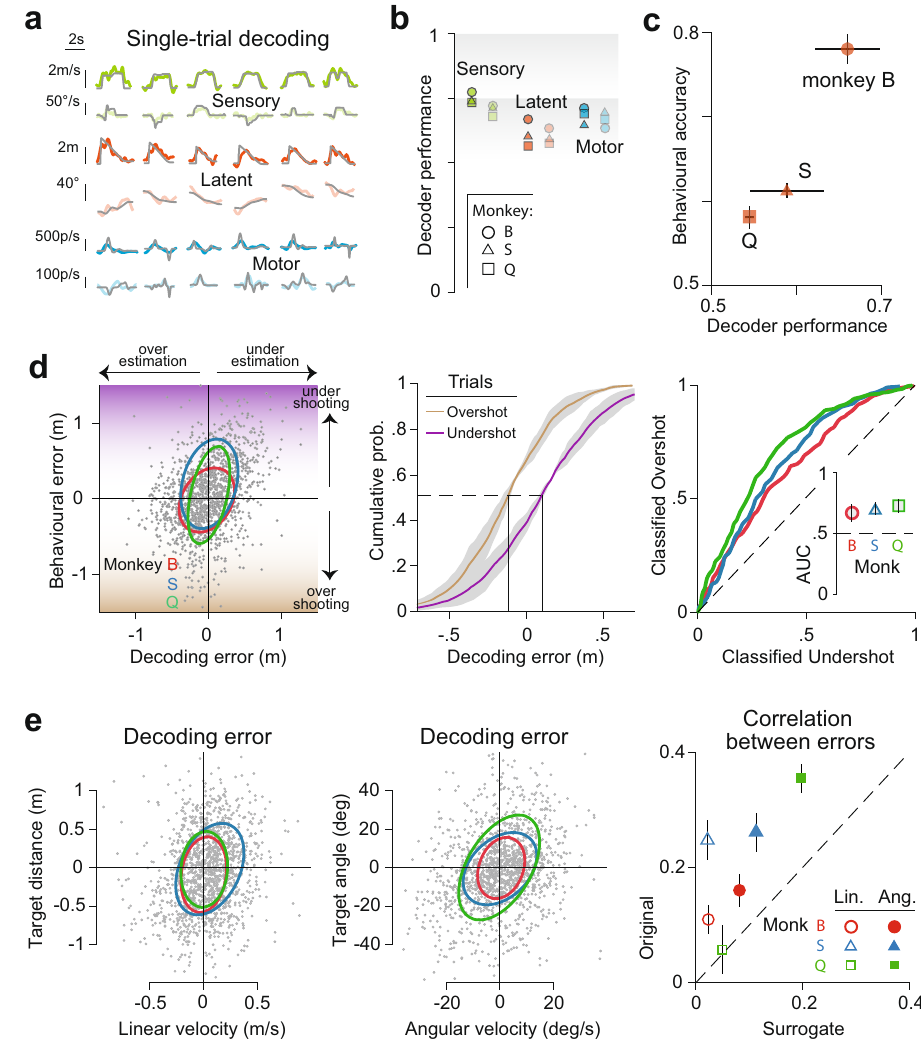
Fig.5|Populationactivitypredictsbehavioronindividualtrials.a Wetraineda linear decoder using ordinary least-squares to decode task variables from popu- lationactivity(Methods).Columnscorrespondtosixrepresentativetrialsandrows correspond to different variables (linear velocity, angular velocity, target distance, targetangle,andhandvelocityalongthetwoleadingprincipalcomponentsofhand position).Graytracescorrespondtogroundtruth. b Decoderperformanceforeach variable, quanti fi ed as the correlation between observed and decoded estimates shown separately for individual monkeys. c Average performance of the decoder for distance-to-target plotted against the mean behavioral accuracy (fraction of correct trials) of different monkeys. d Left: Error in decoding distance to target is correlated with the behavioral error (difference between target distance and stopping distance) across trials. Middle: The cumulative distribution of decoding error shown separately for trials in which the monkey undershoots (purple) or Fig. 5e — right). This suggests that neural computations include a sig- ni fi cant interaction between activity subspaces representing sensory andlatentvariables.SuchaninteractionisconsistentwitharoleofPPC in computing latent world states from sensory inputs.